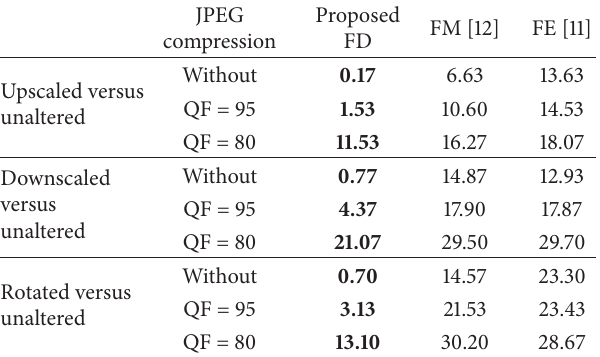
Table2: 𝑃 𝑒 (%)ofeachdetectorondetectingresampledimagesfrom unaltered images. Here “without” means without applying JPEG compressionontestimages.Thebestresultisdisplayedbyboldtexts.